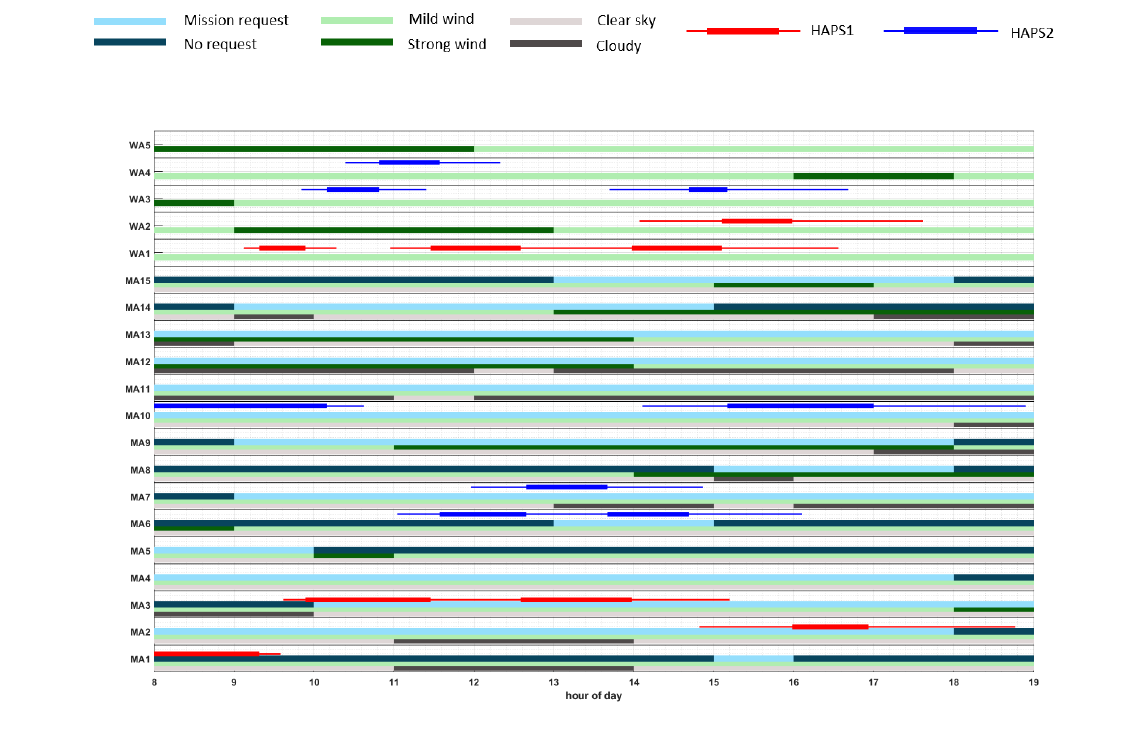
Figure 12. Illustrative example of the feasible MA-level plan with the largest OF rew obtained by PC1 for the second scenario